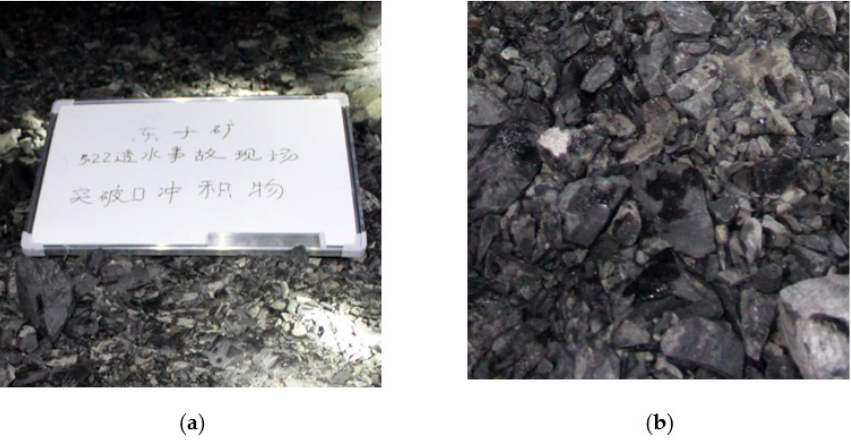
Figure 5. Sandy mudstone, siltstone, and other broken rock deposits in the water inrush site. ( a ) Board marked by the investigation team at the scene of the accident; ( b ) gravel with different particle sizes.